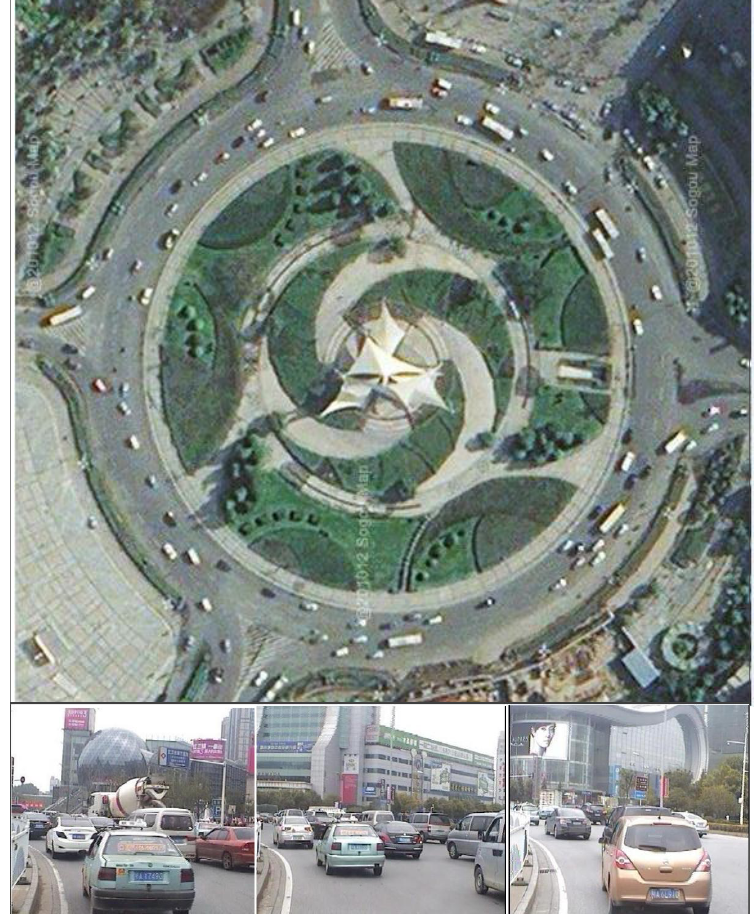
Figure 7. Bird’s eye view of LuXiang Circle and typical traffic scenarios.